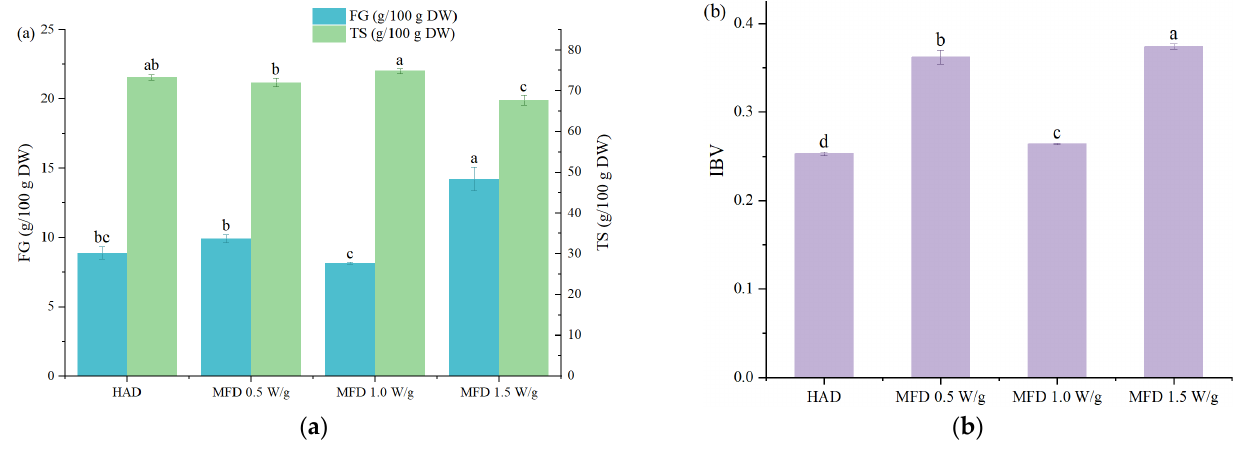
Figure 2. Total starch content, free glucose content ( a ), and iodine blue value ( b ) of yam flours dried by HAD and MFD. Different letters indicate significant differences at p < 0.05.